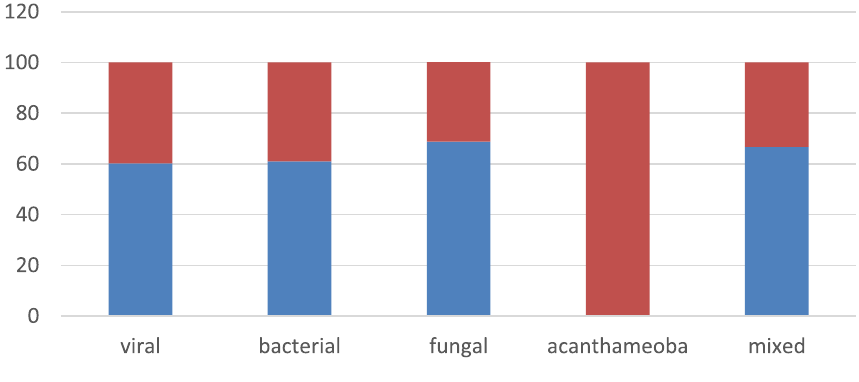
Fig. 7 The distribution of cases according to